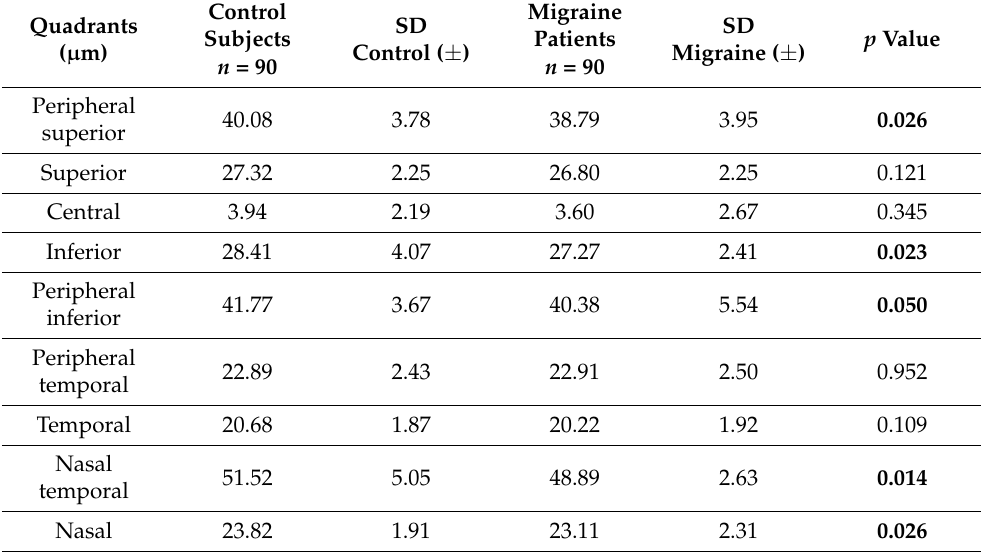
Table 7. RNFL macular thickness ( µ m) in each of the 90 ◦ quadrants around the macula.